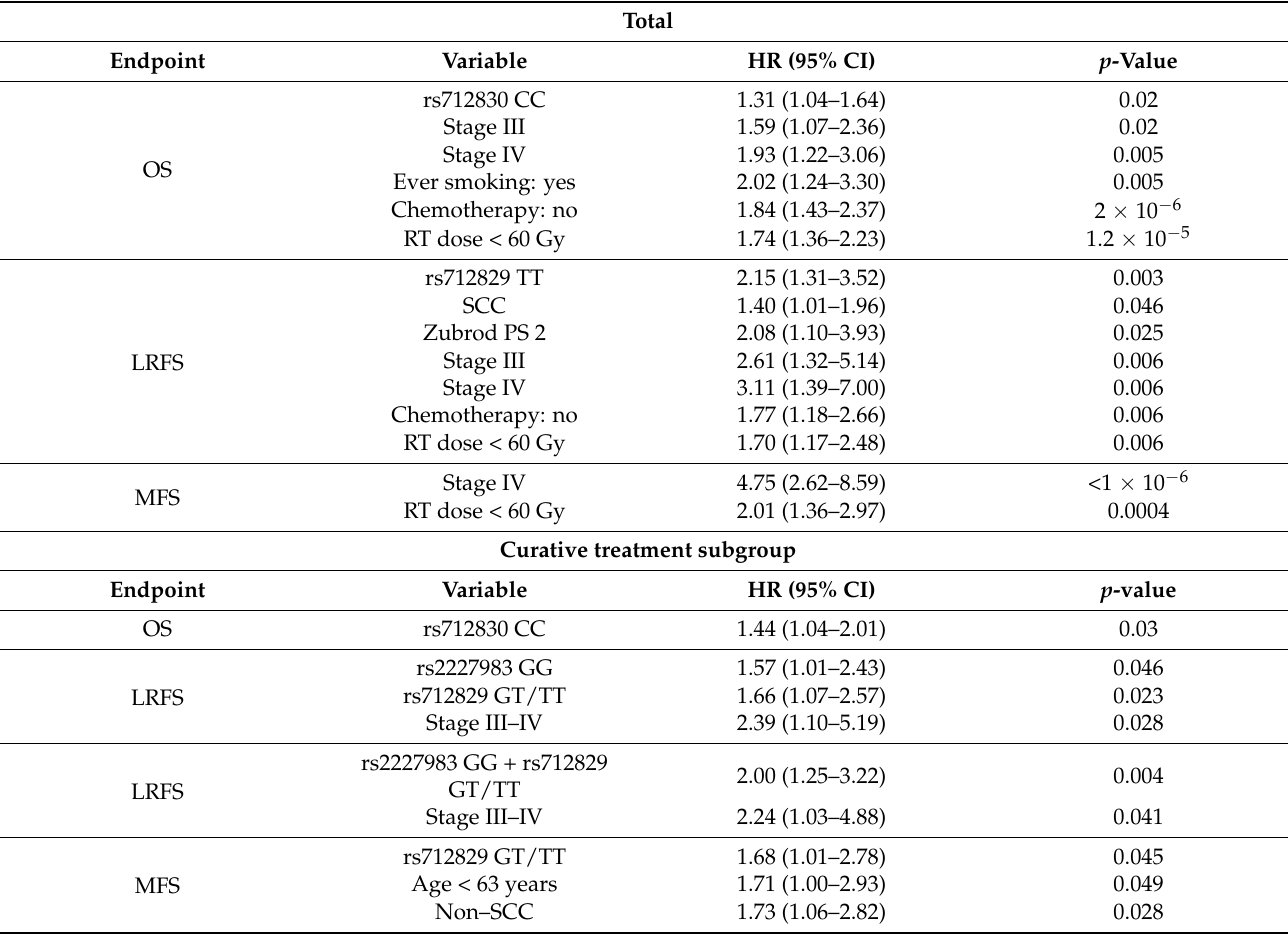
Table 4. Independent risk factors—individual SNPs and tested